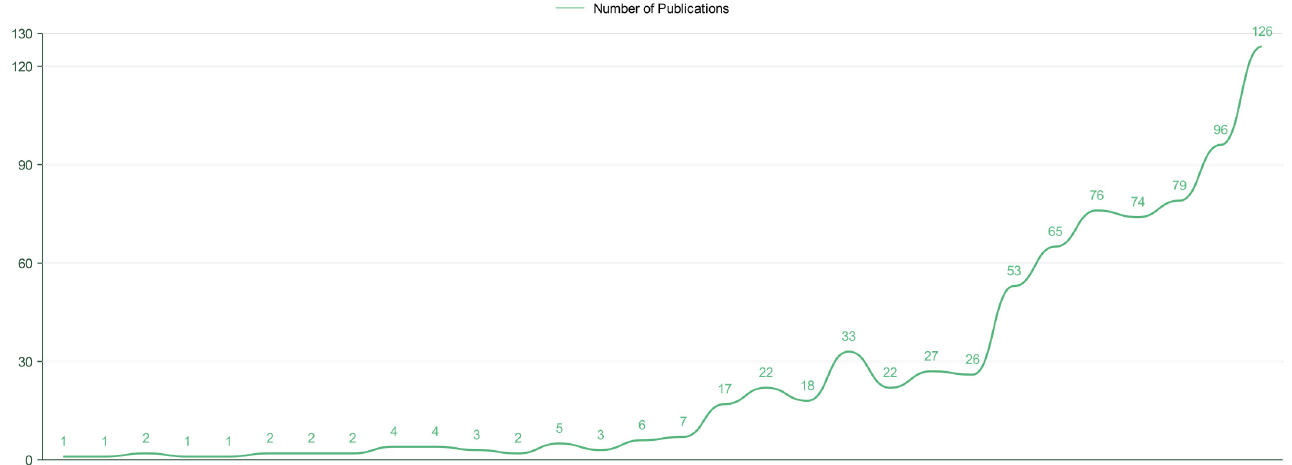
Figure 2. An annual number of publications indexed in the WoS and published from 1980 to 2022.